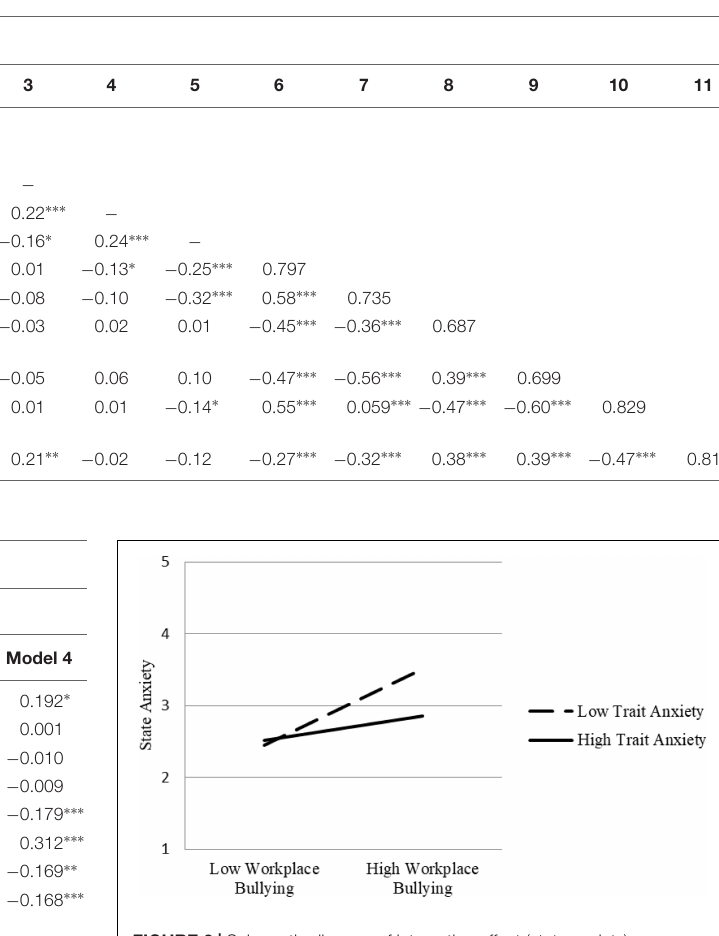
FIGURE 2 | Schematic diagram of interaction effect (state